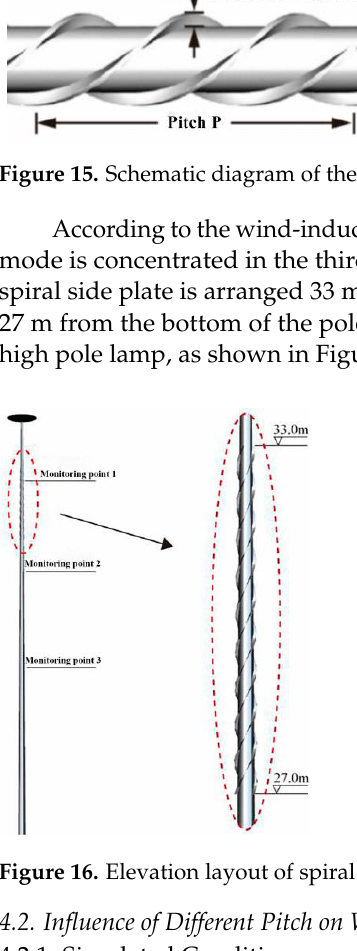
( b ) Fourier spectrum result Figure 14. Crosswind acceleration response at monitoring point 1 under a windspeed of 6 m/s. As indicated in Figure 13, the along-wind acceleration response is dominated by the first-order vibration mode of the structure, with a small part of the second-order vibra- tion mode participating under a windspeed of 6 m/s, which corresponds to the maxi- mum vibration amplitude in the crosswind direction. However, for the crosswind accel- eration response at monitoring point 1, the high-order vibration modal (i.e., the third mode, f = 4.03 Hz) contributes more than the low-order vibration modes. According to Formula (6), the wake-shedding frequency can be calculated as f s = 0.18 × 6/0.26 = 4.15 Hz, which is very close to the third modal frequency of the structure (i.e., f = 4.03 Hz). This result also verifies the correctness of the numerical model built in this study. 4. Wind-Induced Vibration Analysis of High-mast Light Poles with Spiral Helical Strakes The above analysis results show that the smooth high-mast light pole structure is mainly affected by the crosswind vortex-induced vibration within the windspeed range of 5~8 m/s during its service period, which may cause damage or failure of the structure. Therefore, in the following study, the influences of spiral helical strakes on the wind-induced vibration response of high-mast light poles are analyzed. 4.1. Basic Parameters and Layout of Spiral Helical Strakes There are many factors that may affect the characteristics of vibration suppression